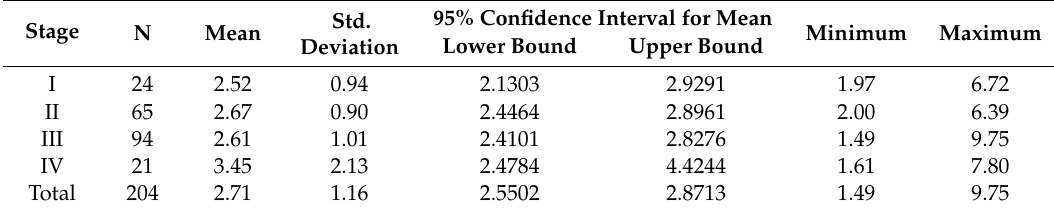
Table 2. NLR mean values for di ff erent tumor